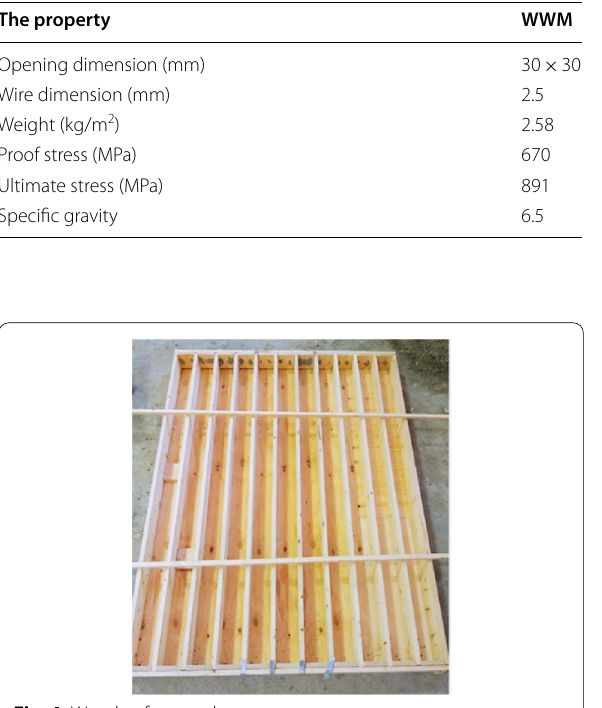
Table 5 Properties of WWM